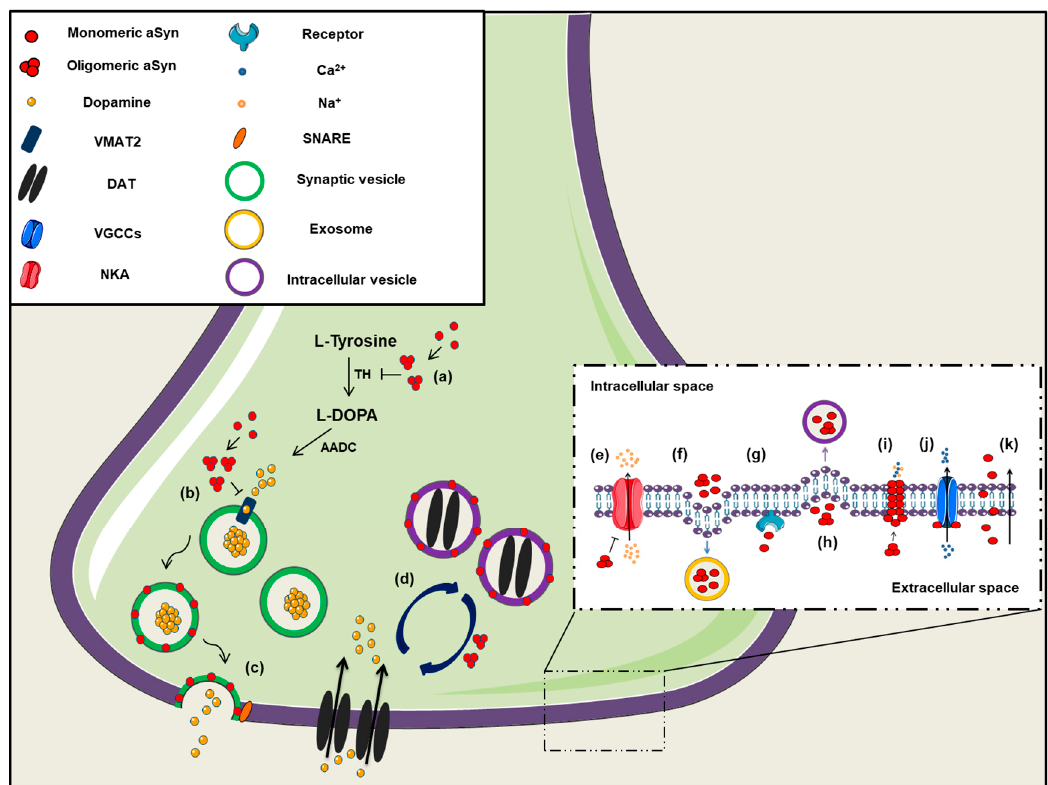
Figure 1. The role of aSyn at the presynaptic terminal. A schematic representation depicting of aSyn physiological and pathological effects at the synapse: (a) aSyn reduces the activity of tyrosine hydroxylase (TH), the enzyme responsible for catalyzing the conversion of L-Tyrosine to L-DOPA, thus impairing dopamine biosynthesis, (b) Increased levels of aSyn inhibit VMAT2, which is responsible for the uptake of monoamines (such as dopamine) into synaptic vesicles, (c) aSyn associates with synaptic vesicle membranes and regulates the SNARE-dependent vesicle fusion and neurotransmitter release, (d) Soluble aSyn interacts with the dopaminergic transporter DAT and decreases its amount on the plasma membrane, thus regulating the dopamine re-uptake from the synapse. However, aSyn aggregates trigger DAT recruitment to the plasma membrane that leads to massive entry of dopamine, (e) aSyn aggregates interact with Na + /K + -ATPase (NKA) preventing the effective pump out of Na + ions, (f) aSyn is secreted from neuronal cells partly via associating with exosomes, (g) Extracellular aSyn interacts with neuronal receptors (i.e., LAG3) for its internalization in neurons or (h) it is up-taken via endocytosis, (i) PD-linked A30P and A53T mutant aSyn form large membrane pores through which most cations (i.e., Ca 2+ ) can pass non-selectively, (j) Extracellular aSyn activates the voltage-gated Ca 2+ channels (VGCCs), resulting in increased Ca 2+ influx, (k) Monomeric aSyn enters neuronal cells via passive diffusion or direct penetration of their plasma membrane.